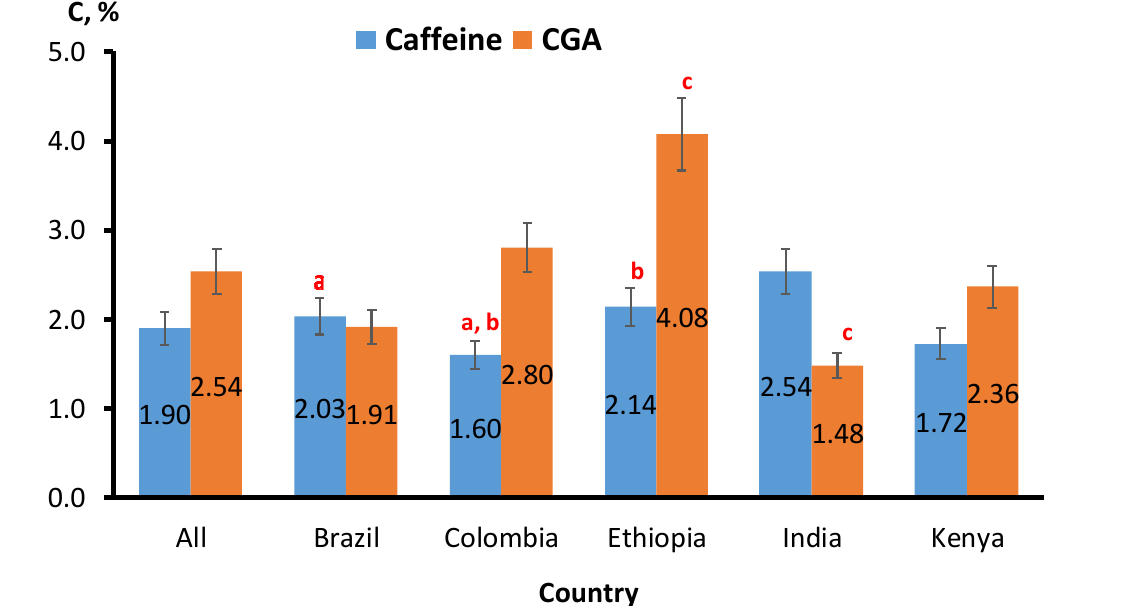
Figure 1. The caffeine and CGA content (C, %) in coffee beans from different geographical origin (different roasting degrees). More details concerning the number of samples for each origin are available in the Supplementary Table S1. Bars labeled by the letters a,b,c are statistically significant ( p < 0.05).